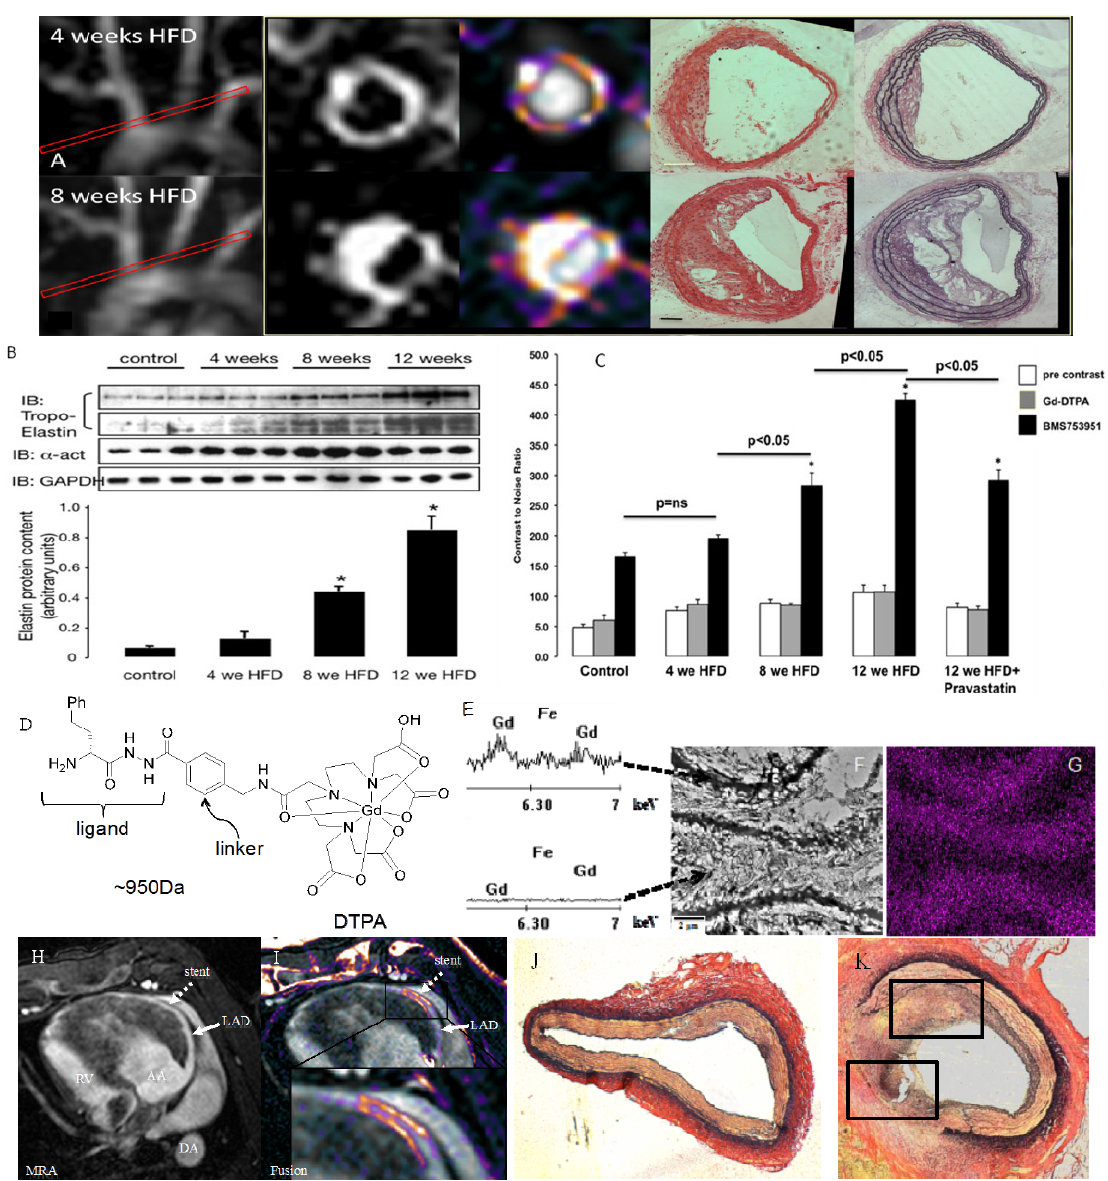
Figure 9. ( A ) MRI of extracellular matrix remodeling in an apoE − / − mouse model of accelerated atherosclerosis at 4 and 8 weeks after commencement of HFD using an elastin specific MR contrast agent ( D ), ESMA (Lantheus Medical Systems, North Billerica, MA, USA). ( B , C ) Contrast-to-noise values after ESMA injection increased with the duration of the HFD, which was paralleled by an increase in tropoelastin by western blotting. Electon microscopy of elastin fibers ( F ) and X-ray spectroscopy of gadolinium (Gd) ( E , G ) showed preferential uptake of ESMA along the elastic fibers with little to no uptake in-between elastin fibers (F,G). (F) ESMA MRI of mechanical coronary wall injury after MR lucent stent placement ( H ) showed focal signal enhancement in the stented area ( I ), which was in agreement with extracellular matrix remodeling on histology ( J , K ) (adapted from Makowski [80] and von Bary